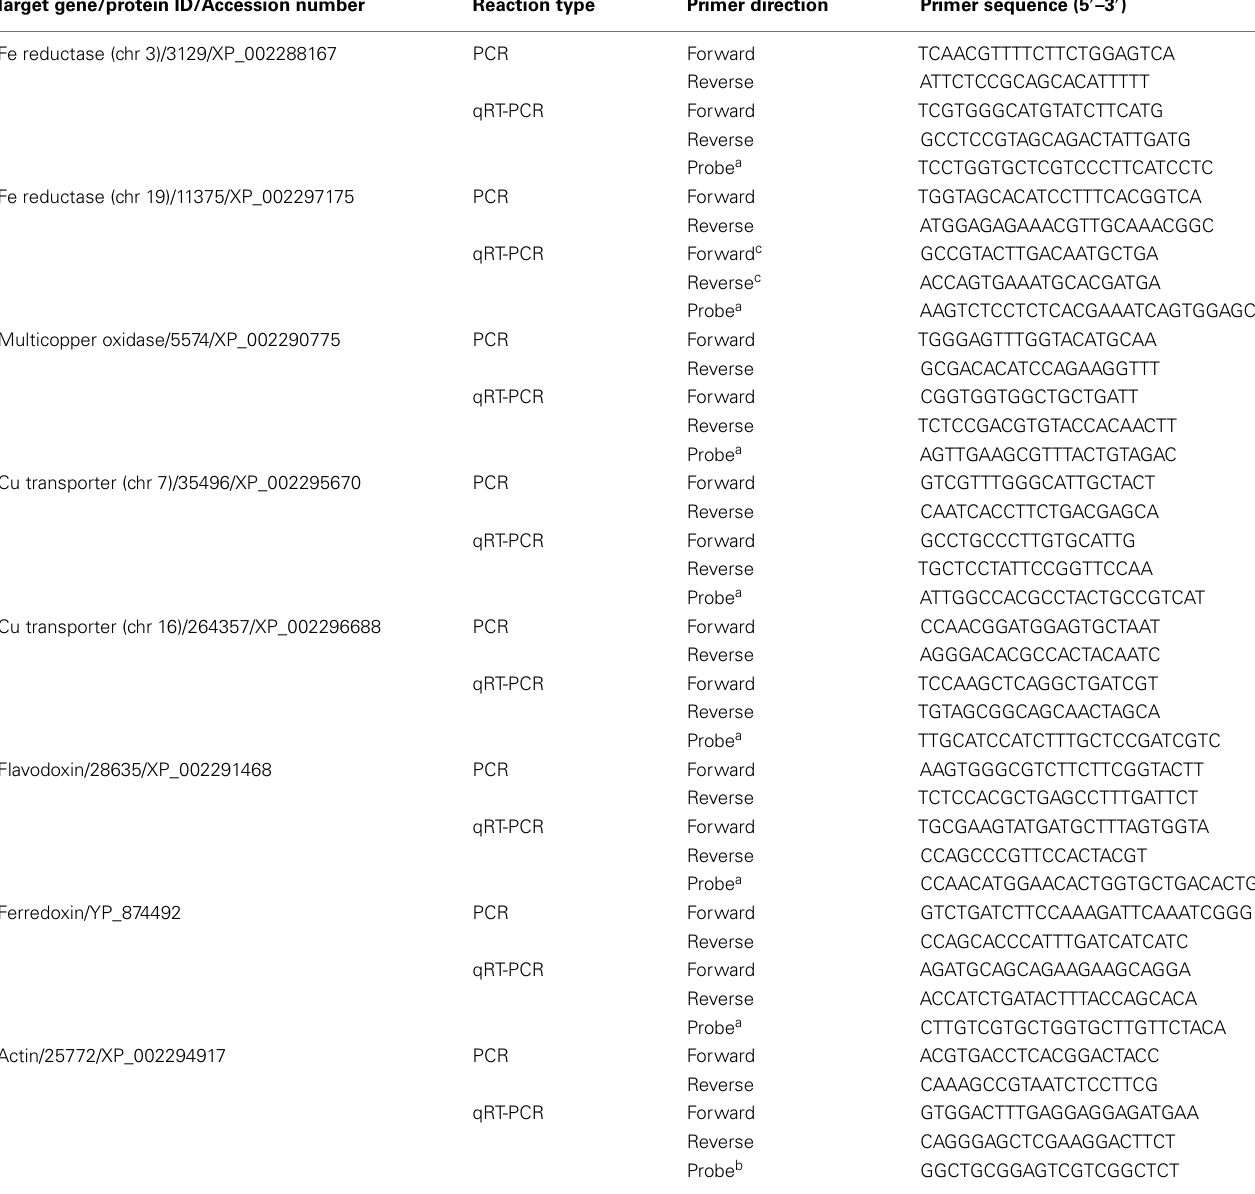
Table 1 | Genes and primers used to amplify targets for plasmid standards (PCR) and measure transcript abundance (qRT-PCR) in T. pseudonana . Target gene/protein ID/Accession